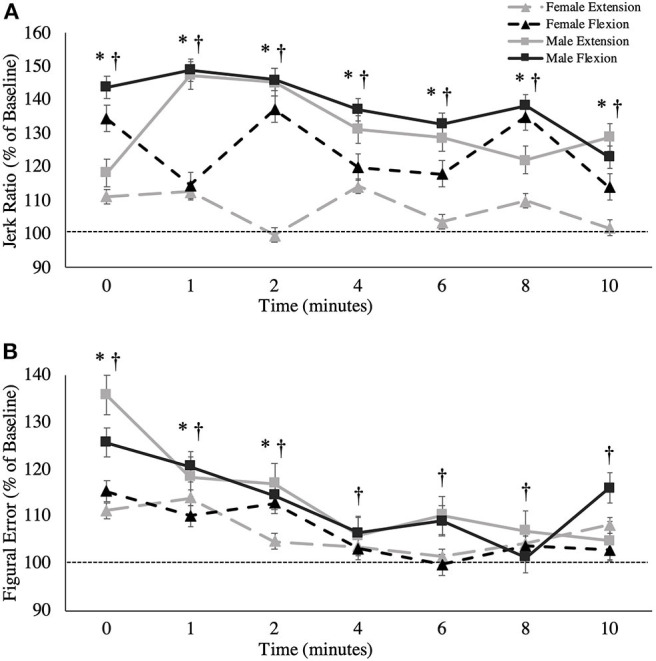
(A) Jerk ratio (percentage of baseline) and (B) figural error (percentage of baseline) across all time points. This metric is presented as group averages (with standard error bars). The dashed line represents baseline error. The data is separated by sex and muscle group. † = data are significantly different between sexes; * = pooled data are significantly different from baseline.